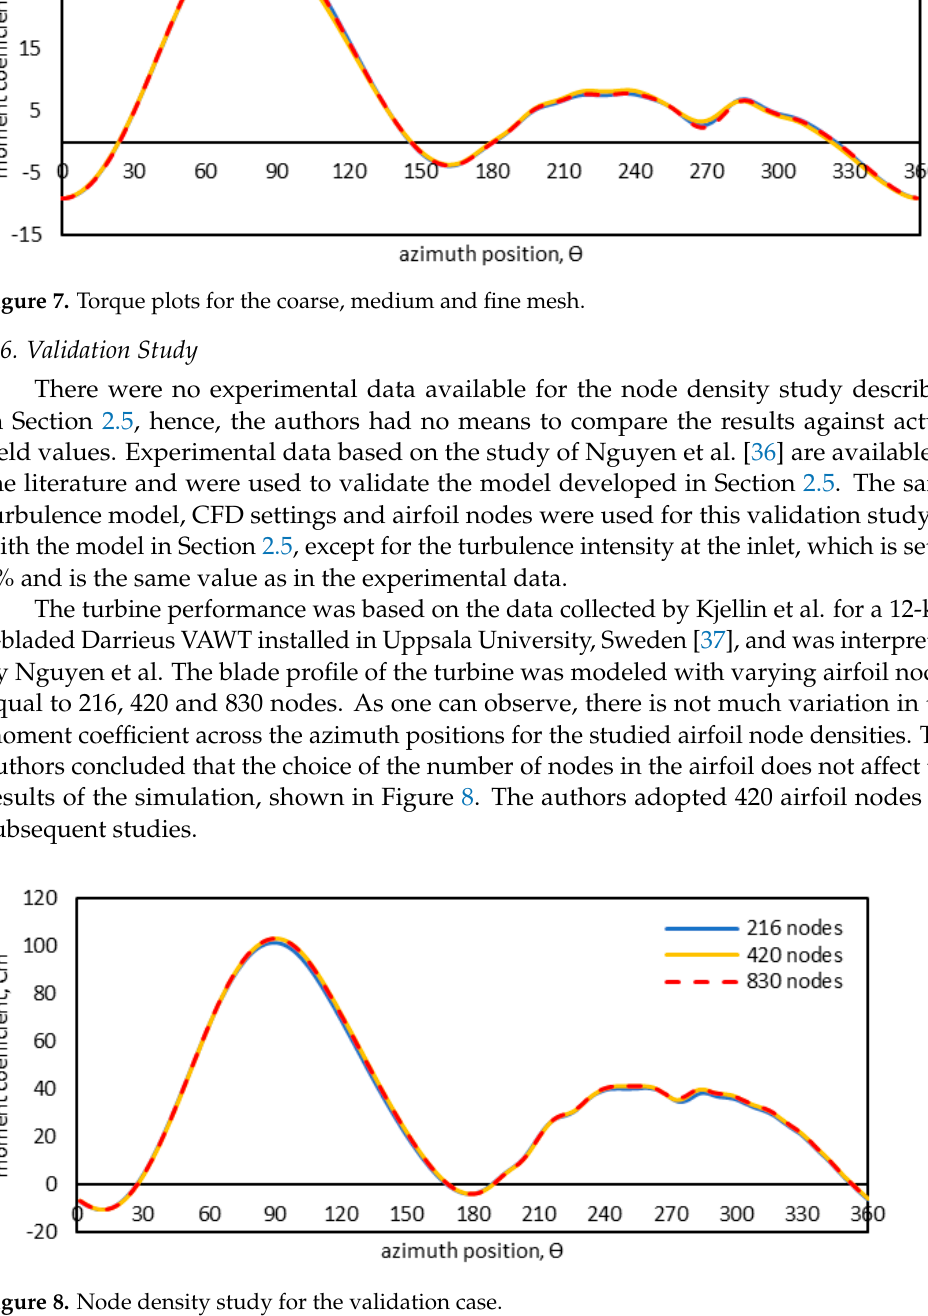
Figure 9. Airfoil normal force comparison between experimental data and CFD simulation across different azimuth positions. Figure 10. Airfoil normal force comparison between experimental data at time step sizes of 1° and 2° equivalent rotation. 2.7. Simulation Phases The preliminary phase of the study involves the investigation of the appropriate time step size for the simulation, the number of nodes necessary for the airfoil shape,